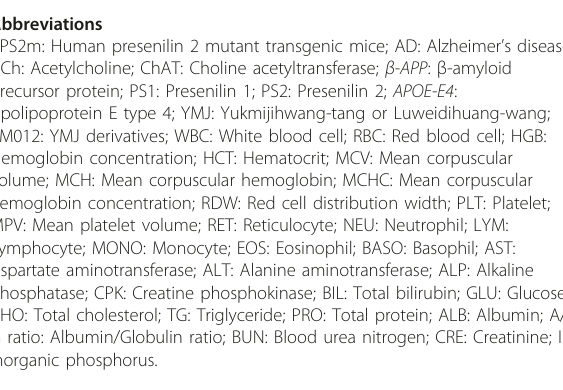
Additional file 1: Table S1 . Urinalysis in rats orally treated with